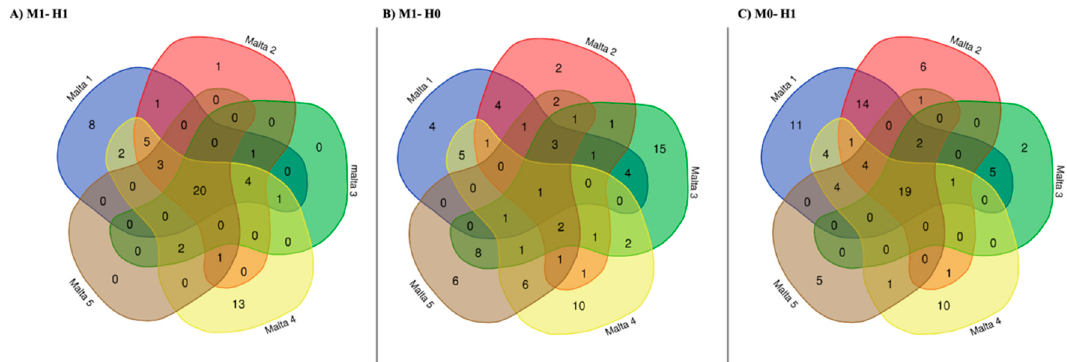
Figure 3. Comparison among the genes found in all five samples with the same DNA methylation status (previously estimated in Figure 1). In particular, ( A ) reports the results of the comparison of the genes identified in each sample for the M1-H1 condition, ( B ) those for M1-H0 condition, and ( C ) those in M0-H1 condition. The list of shared or private genes is reported in Table